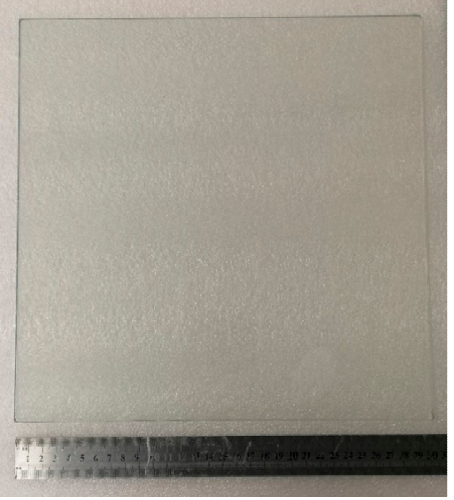
Figure 8. Photograph of the fabricated absorber sample.